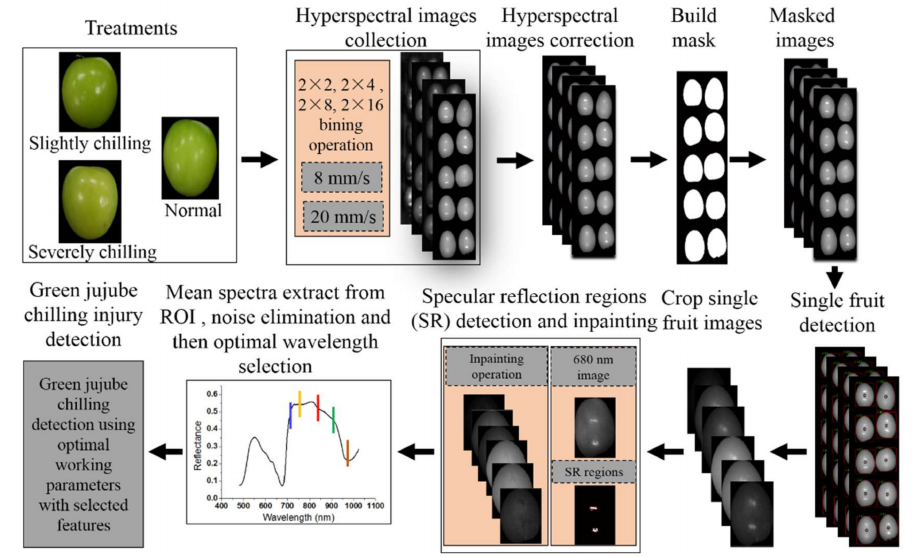
Figure 1. The pipeline of green jujube chilling injury detection based on hyperspectral imaging